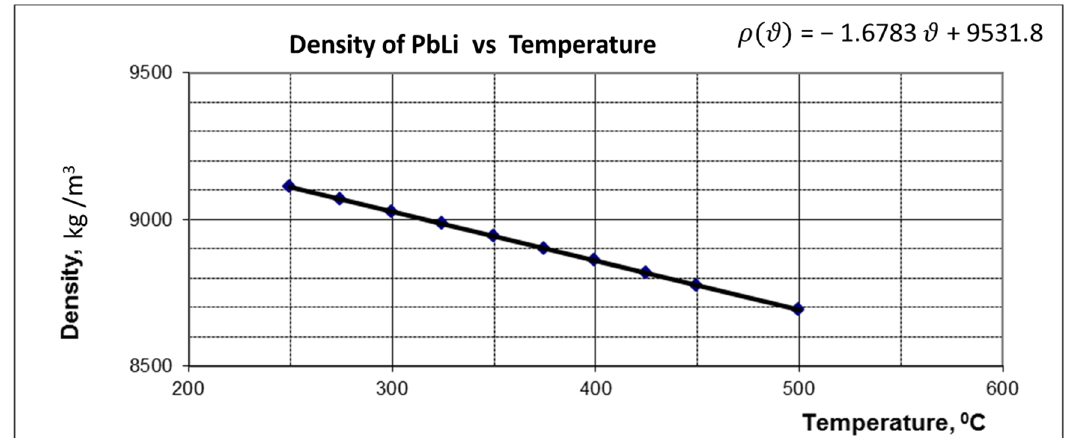
Figure 8. Variation of PbLi density with temperature.